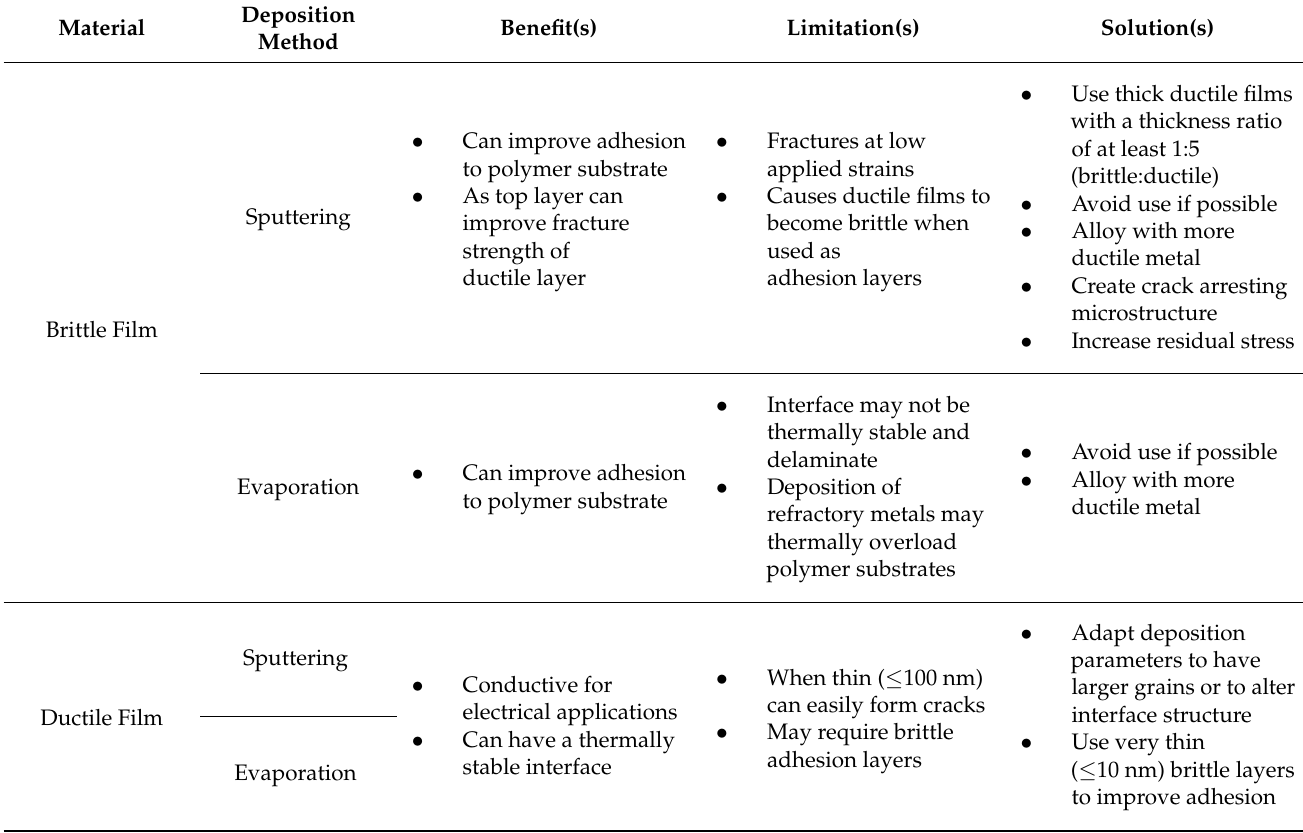
Table 2. Summary of benefits, limitations, and possible solutions for fabricating robust brittle or ductile metal films on polymer